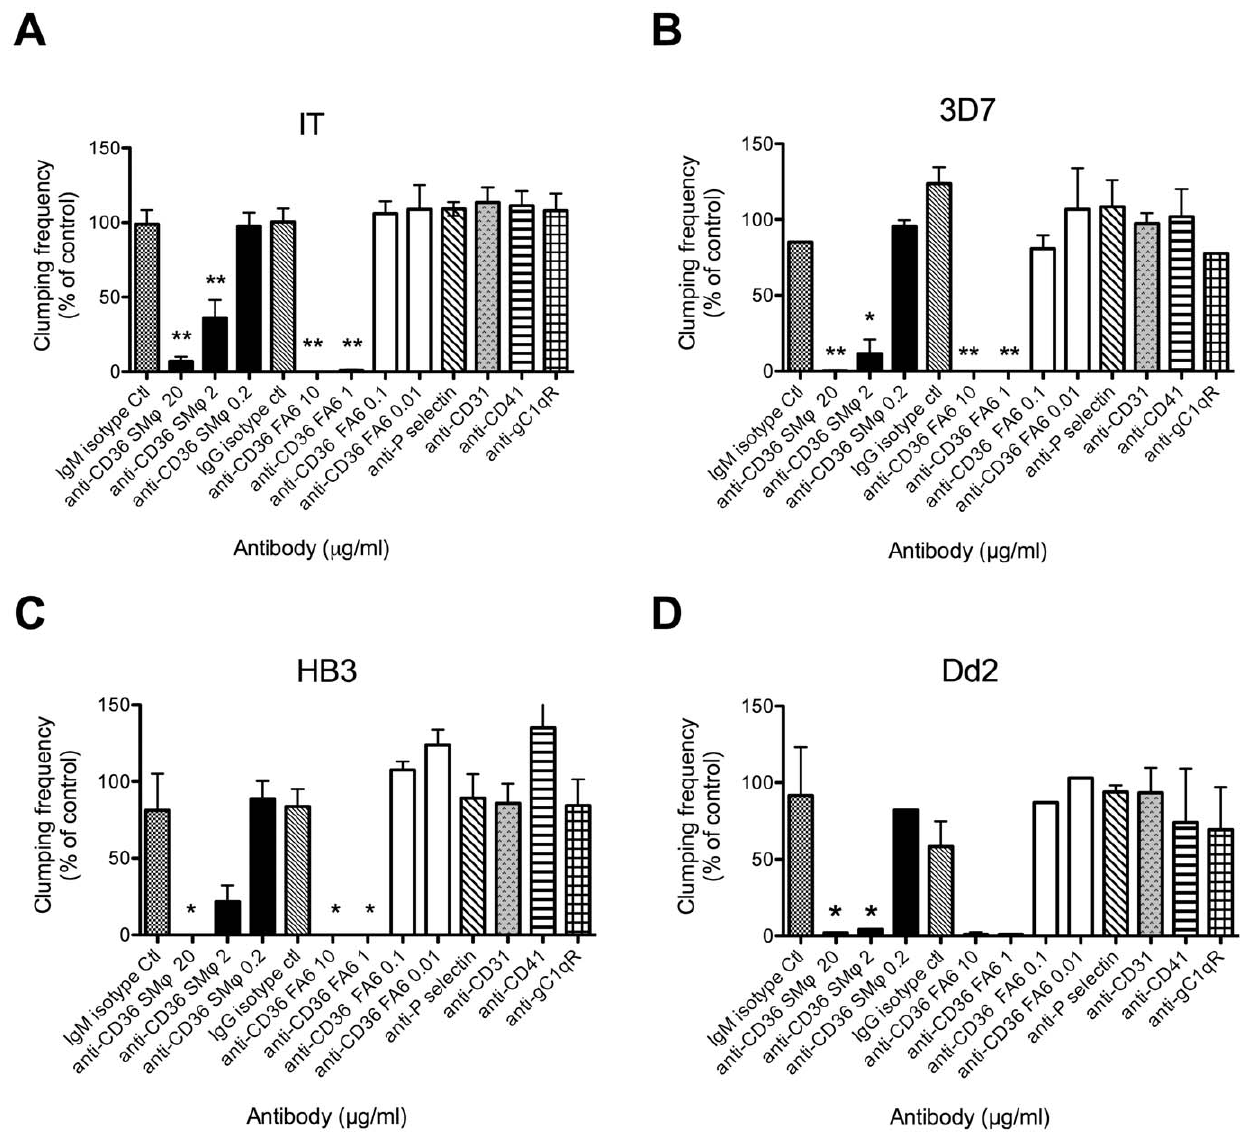
Figure 3. Inhibition of platelet-mediated clumping of P.falciparum infected erythrocytes (IEs) by antibodies to platelet receptors. Platelets were pre-incubated with antibodies for 45 mins before being used to set up clumping assays. All antibodies were at 20 m g/ml except anti- CD36 mAb clone SM w (also 2 and 0.2 m g/ml) and anti-CD36 mAb clone FA6-12 (10, 1, 0.1 and 0.01 m g/ml). Platelet-mediated clumping assays were set up at 10% Ht, 1% Pt, and 20% PRP, at pH7.3, and the clumping frequency (percentage of IEs in clumps out of 500 IEs counted) was assessed by fluorescence microscopy of two wet preparations at time point 1 h. To normalize between experiments with different baseline clumping frequencies, the data are shown as percentage of a control with no added antibody. Data shown are the mean and standard error (SE) of CF. (A) Parasite strain IT (six independent experiments), (B) 3D7 (two experiments), (C) HB3 (three experiments; value of SE for anti-CD41 is 29) and (D) Dd2 (two experiments). One-way ANOVA showed a significant effect of antibodies on P. falciparum clumping (p , 0.005) for all strains, with CD36 antibodies showing significant inhibition in all cases (Tukey’s multiple comparison test, * p , 0.05, ** p , 0.005).